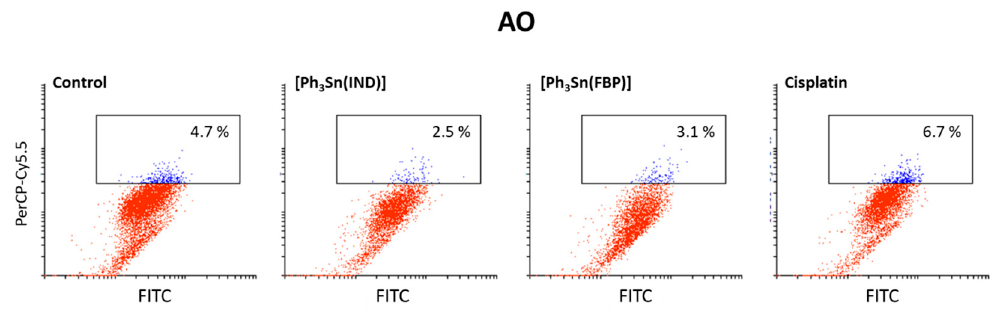
Figure 6. Autophagy induction in BT-474 cells upon 48 h treatment with organotin(IV) complexes ([Ph 3 Sn(IND)] and [Ph 3 Sn(FBP)]) and cisplatin.